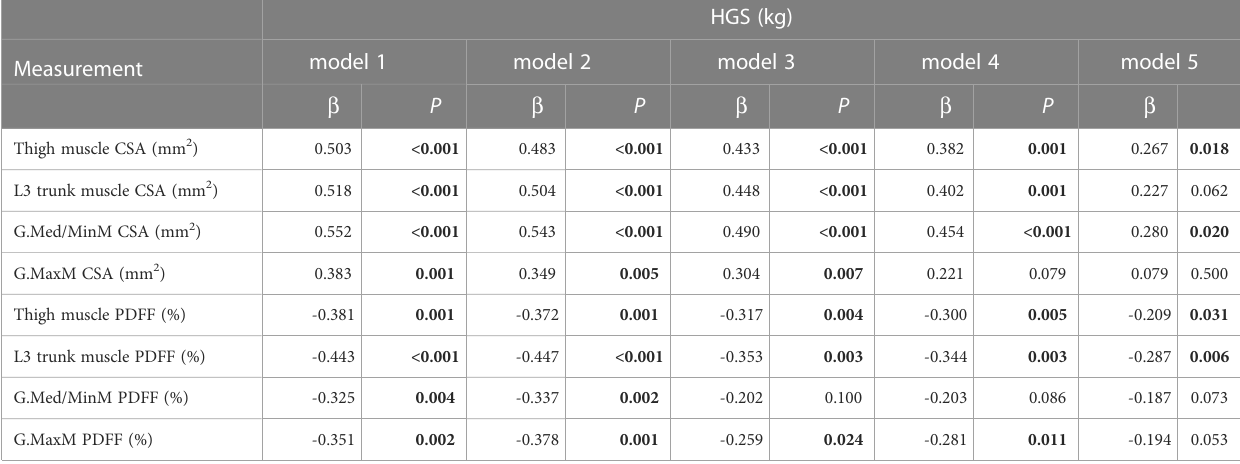
TABLE 2 Independency of muscle measurements and handgrip strength.